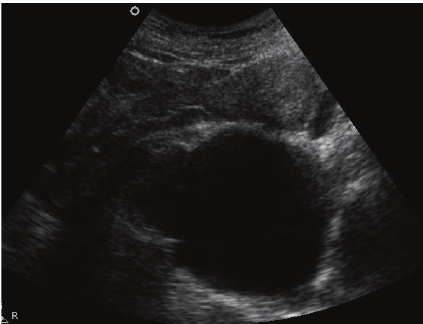
Figure 1: Sagittal ultrasound image of the pelvic area showing a thin-walled cystic lesion compressing the uterus on the posterior.